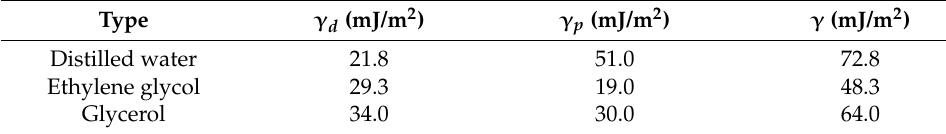
Table 2. Surface free energy parameters of the test liquids.